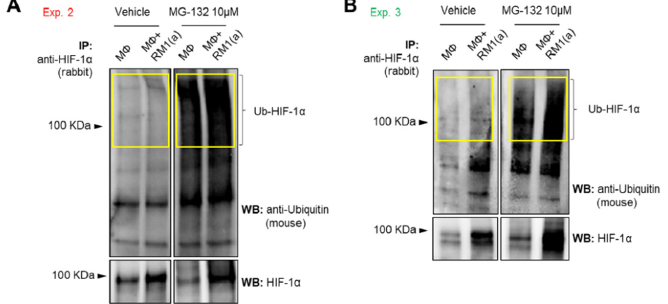
Figure A3. Ubiquitin detection in HIF-1 α immunoprecipitated (IP) from efferocytic and non-ef- ferocytic BM macrophages. BM macrophages (M Φ ) were isolated from 4 wk old C57BL/6J mice and co-cultured with apoptotic RM1(a) cells for 4 h and treated with 10 µ M MG-132 (degradation inhibitor of ubiquitin-conjugated proteins) for 1 h ( n = 2). Cell lysates from efferocytic and non-efferocytic BM macrophages were immunoprecipitated (IP) with HIF-1 α antibody and immunoblotted with ubiquitin and HIF-1 α antibodies as shown in ( A ) Experiment 2 and ( B ) Experiment 3. Ub-HIF-1 α (ubiquitinated HIF-1 α ) signal was measured in the yellow box around the corresponding HIF-1 α molecular